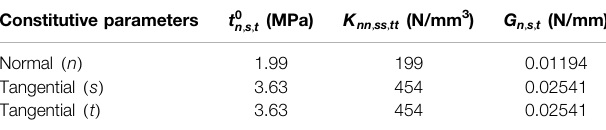
TABLE 1 | Constitutive parameters of the non-toughened epoxy bonding interface. Constitutive